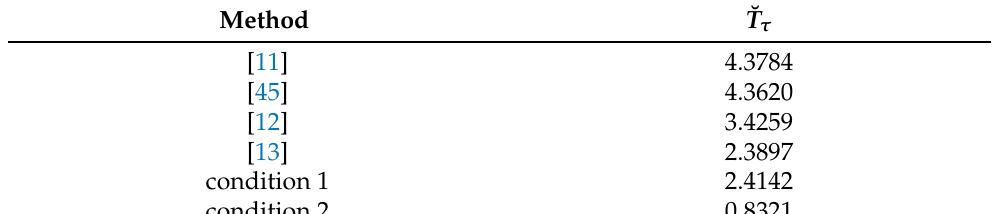
Table 5. The comparison of the different fixed time ˘ T τ .